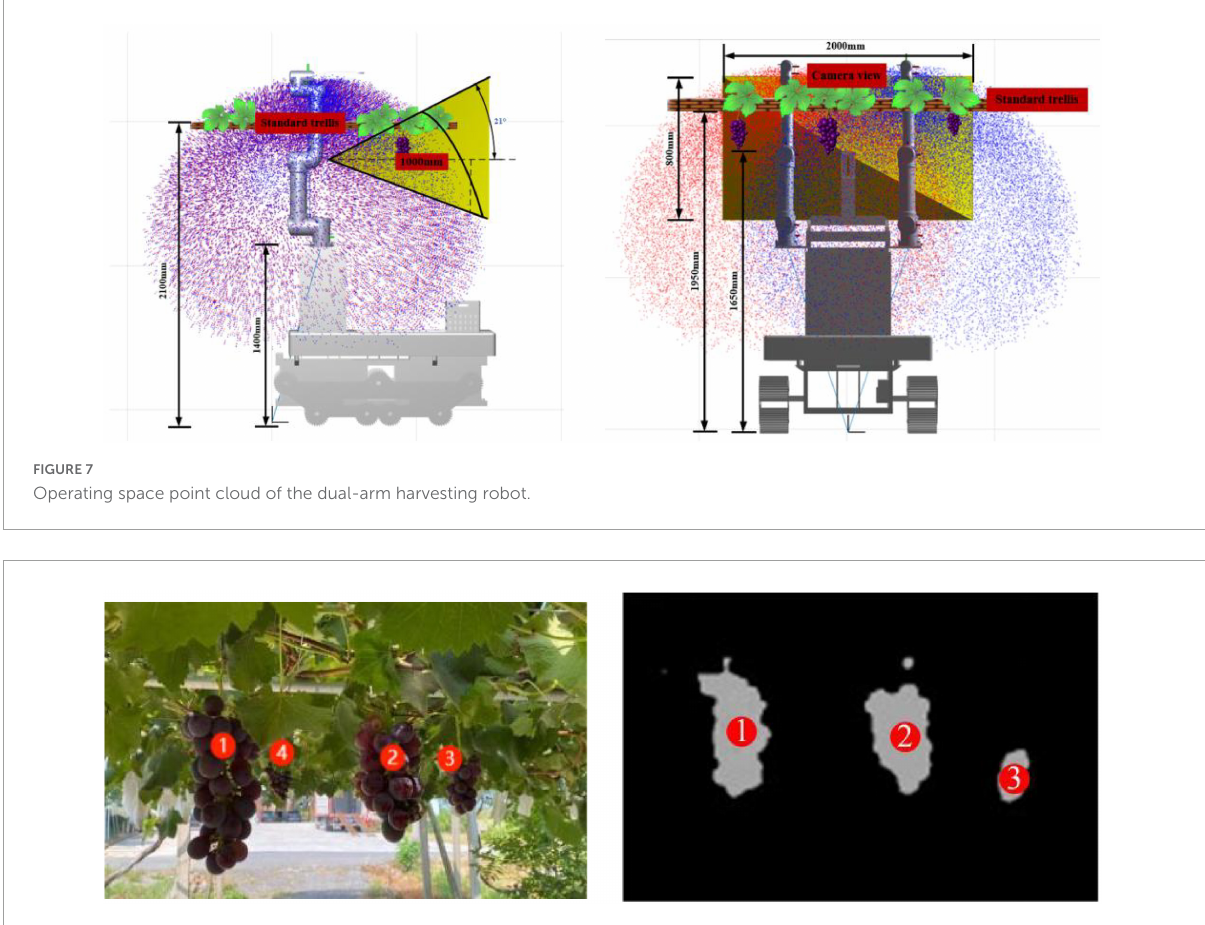
FIGURE8 Identification of multiple bunches of grape clusters within one image.